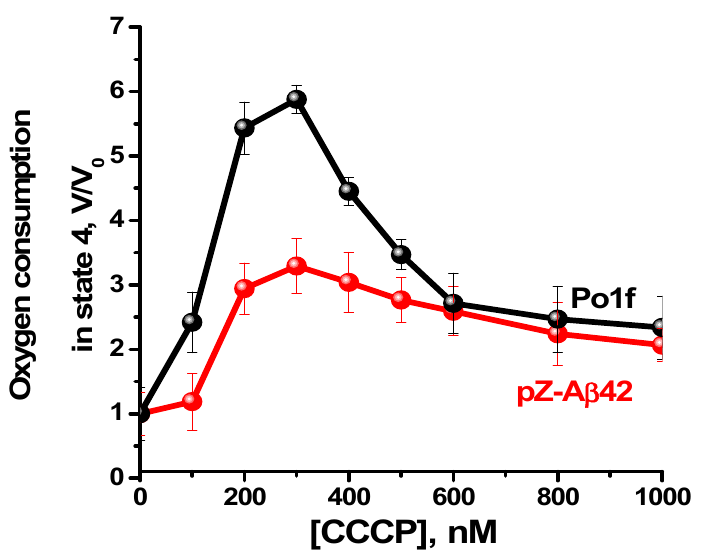
Figure 5. Oxygen consumption by Y. lipolytica mitochondria. The incubation medium was supplemented with 20 mM Tris-pyruvate + 5 mM Tris-malate and mitochondria (0.2 mg protein/mL). cells retained an intact structure of the respiratory chain, as shown from the analysis of respiratory titration curves by specific inhibitors (i.e., rotenone (for Complex I) (Figure 6A) and antimycin A (AA, for Complex III) (Figure 6B)). Thus, A β 42 expression most likely does not disturb the functioning of complexes I and III of the respiratory